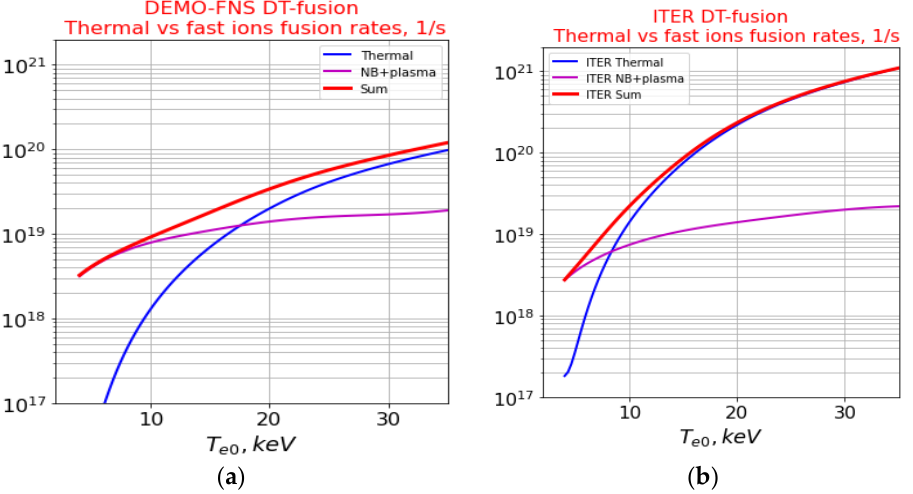
Figure 8. DT fusion rates across plasma temperature: ( a ) DEMO-FNS ( n e 0 = 1 × 10 20 m −3 , E b = 500 keV); ( b ) ITER ( n e 0 = 1.2 × 10 20 m −3 , E b = 1 MeV).